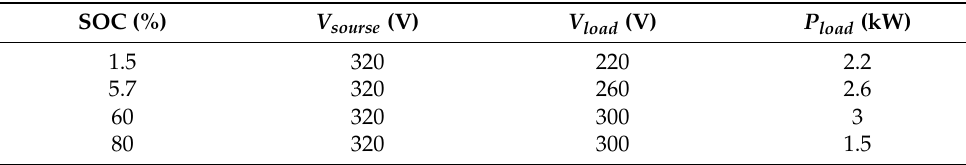
Table 5. Testing conditions extracted from Figure 11.